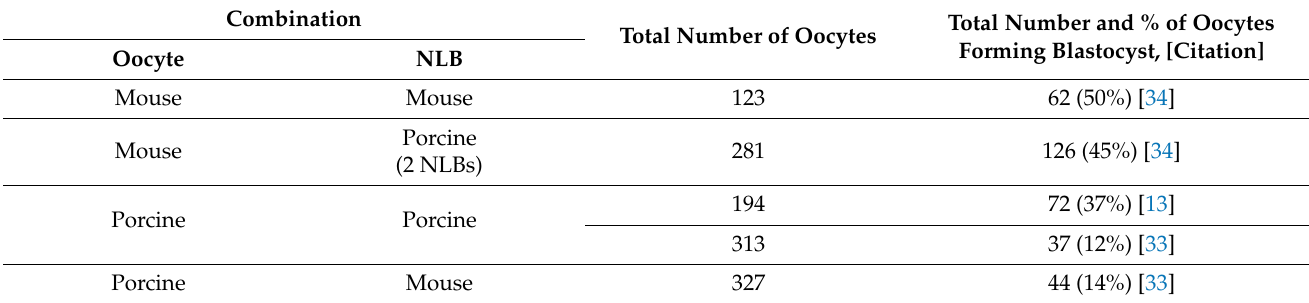
Table 1. In vitro development of embryos derived from enucleolated and re-injected